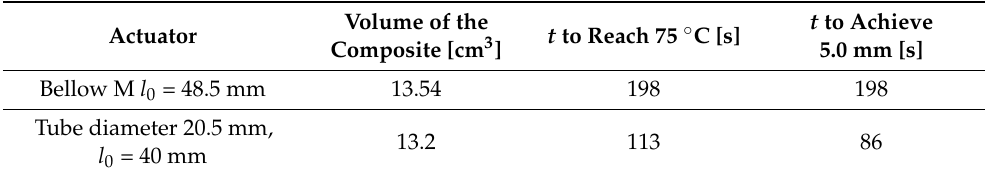
Table 4. Comparison of selected actuators. All actuators were heated with a current of approximately 1 A with heaters with this same resistance.